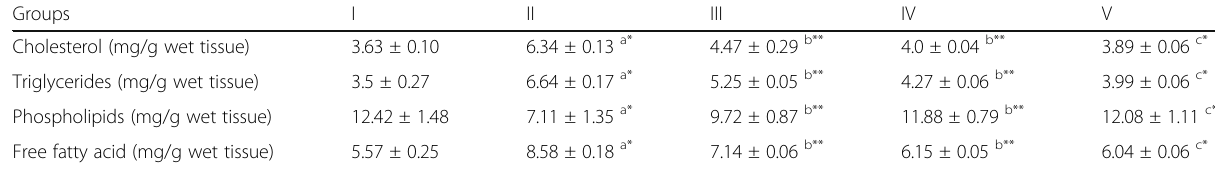
Table 4 Effect of aqueous extract of Caesalpinia bonducella L. on tissue lipid profile in experimental animals